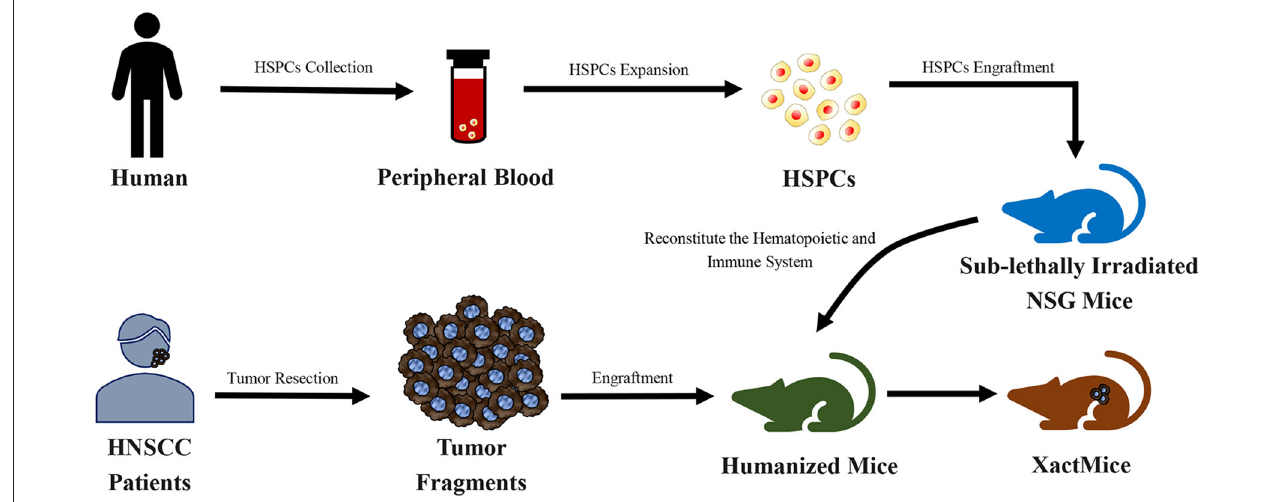
FIGURE 5 | Schematic diagram of the generation of xenochimeric mice (XactMice) (162). After the cells are harvested from either cord blood or Granulocyte Colony-stimulating Factor (G-CSF) mobilized adult peripheral blood, the human hematopoietic stem and progenitor cells (HSPCs), which contain hematopoietic stem cells (HSCs), were expanded by an ex vivo technique and injected into sub-lethally irradiated NOD/SCID/ IL2rg − / − (NSG) mice to reconstitute the hematopoietic and immune system. Subsequently, tumor tissue from head and neck squamous cell carcinoma (HNSCC) patients were engrafted into NSG mice to generate the